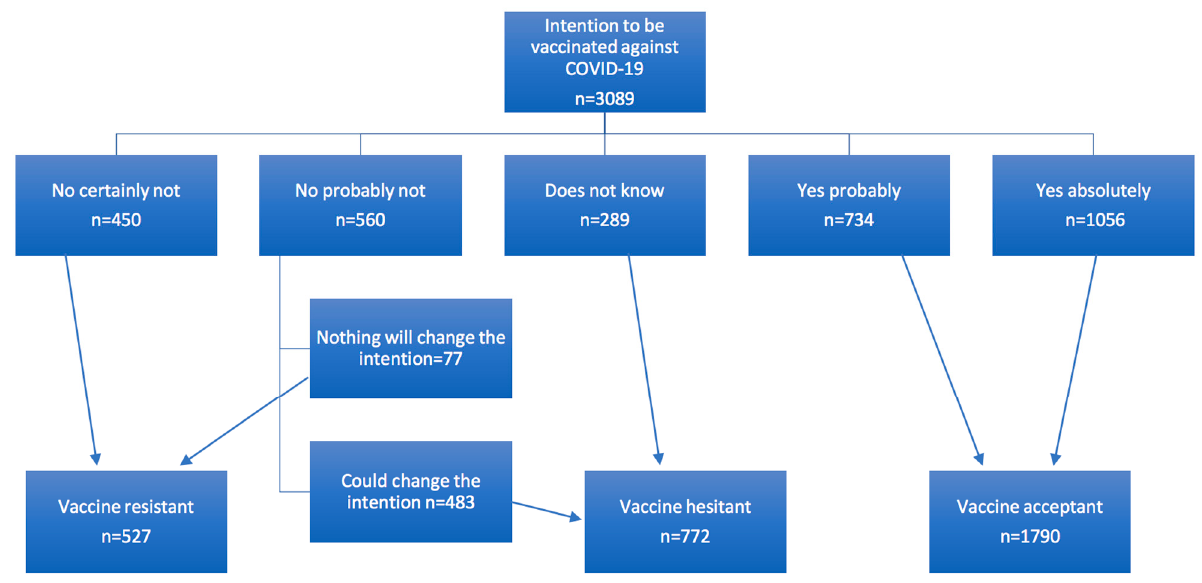
Figure 1. Classification on COVID-19 vaccine acceptant, hesitant and resistant.